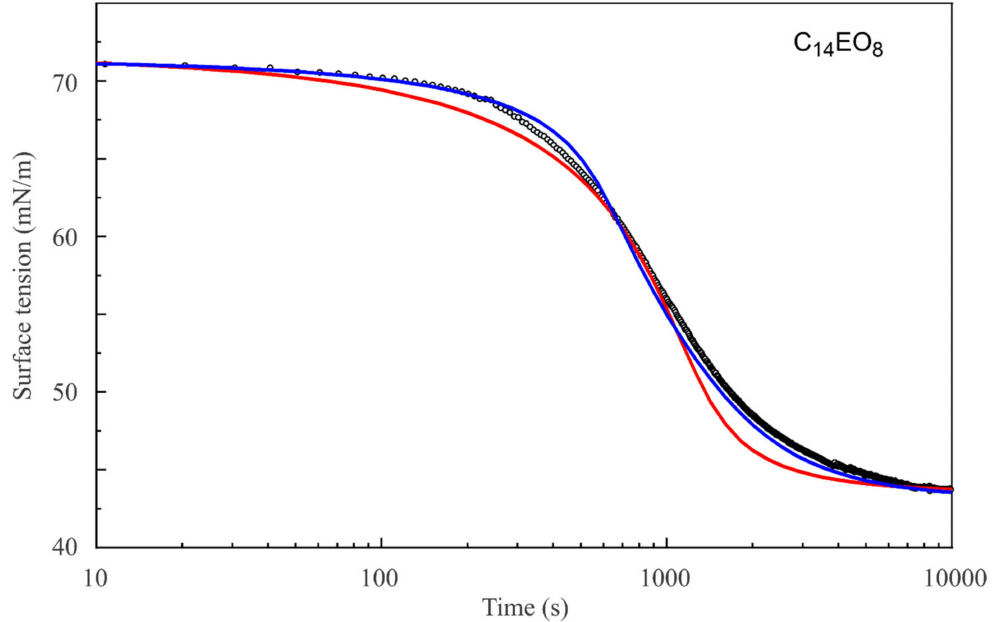
Figure 2. Experimental surface tensions as a function of time measured by PAT-2 for a 1 µ mol/L C 14 EO 8 solution (symbols) and the respective theoretical curves calculated for the reorientation model (blue line) and the Frumkin model (red line), respectively, with a diffusion coefficient of 8 × 10 − 10 m 2 /s.